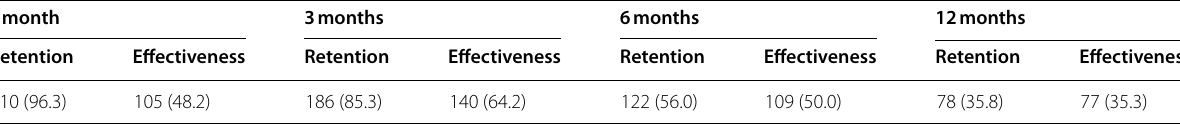
Data are provided as n